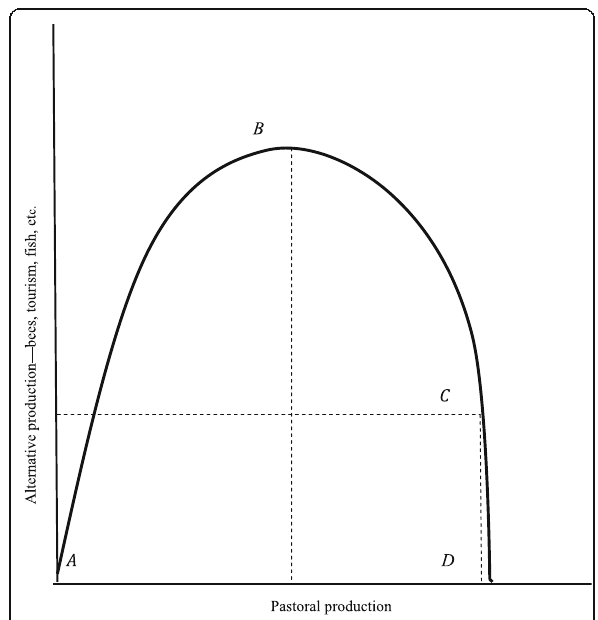
Fig. 2 Complementary, supplementary and competitive production in the use of common pastoral resources